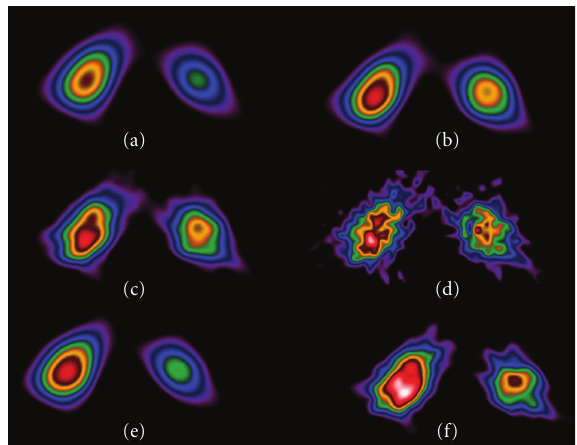
Figure 8: Transverse slices of kidneys’. Various pre- postfiltered in FBP reconstruction were applied with di ff erent e ff ects on the images Filters used were (a) prefilter Hanning (cut-o ff 0.8cm − 1 ), postfilter Ramp. (b) prefilter Butterworth (cut-o ff 0.5cm − 1 power value 10), postfilter Ramp. (c) prefilter Butterworth (cut-o ff 0.8cm − 1 , power value 10), postfilter Ramp. (d) only Ramp prefilter applied—no other smoothing filter. (e) prefilter Ramp, postfilter Hanning (cut o ff 0.8cm − 1 ) (f) prefilter Ramp, postfilter Butterworth (cut-o ff 0.8cm − 1 , power value 10). Study has been completed in Radiation